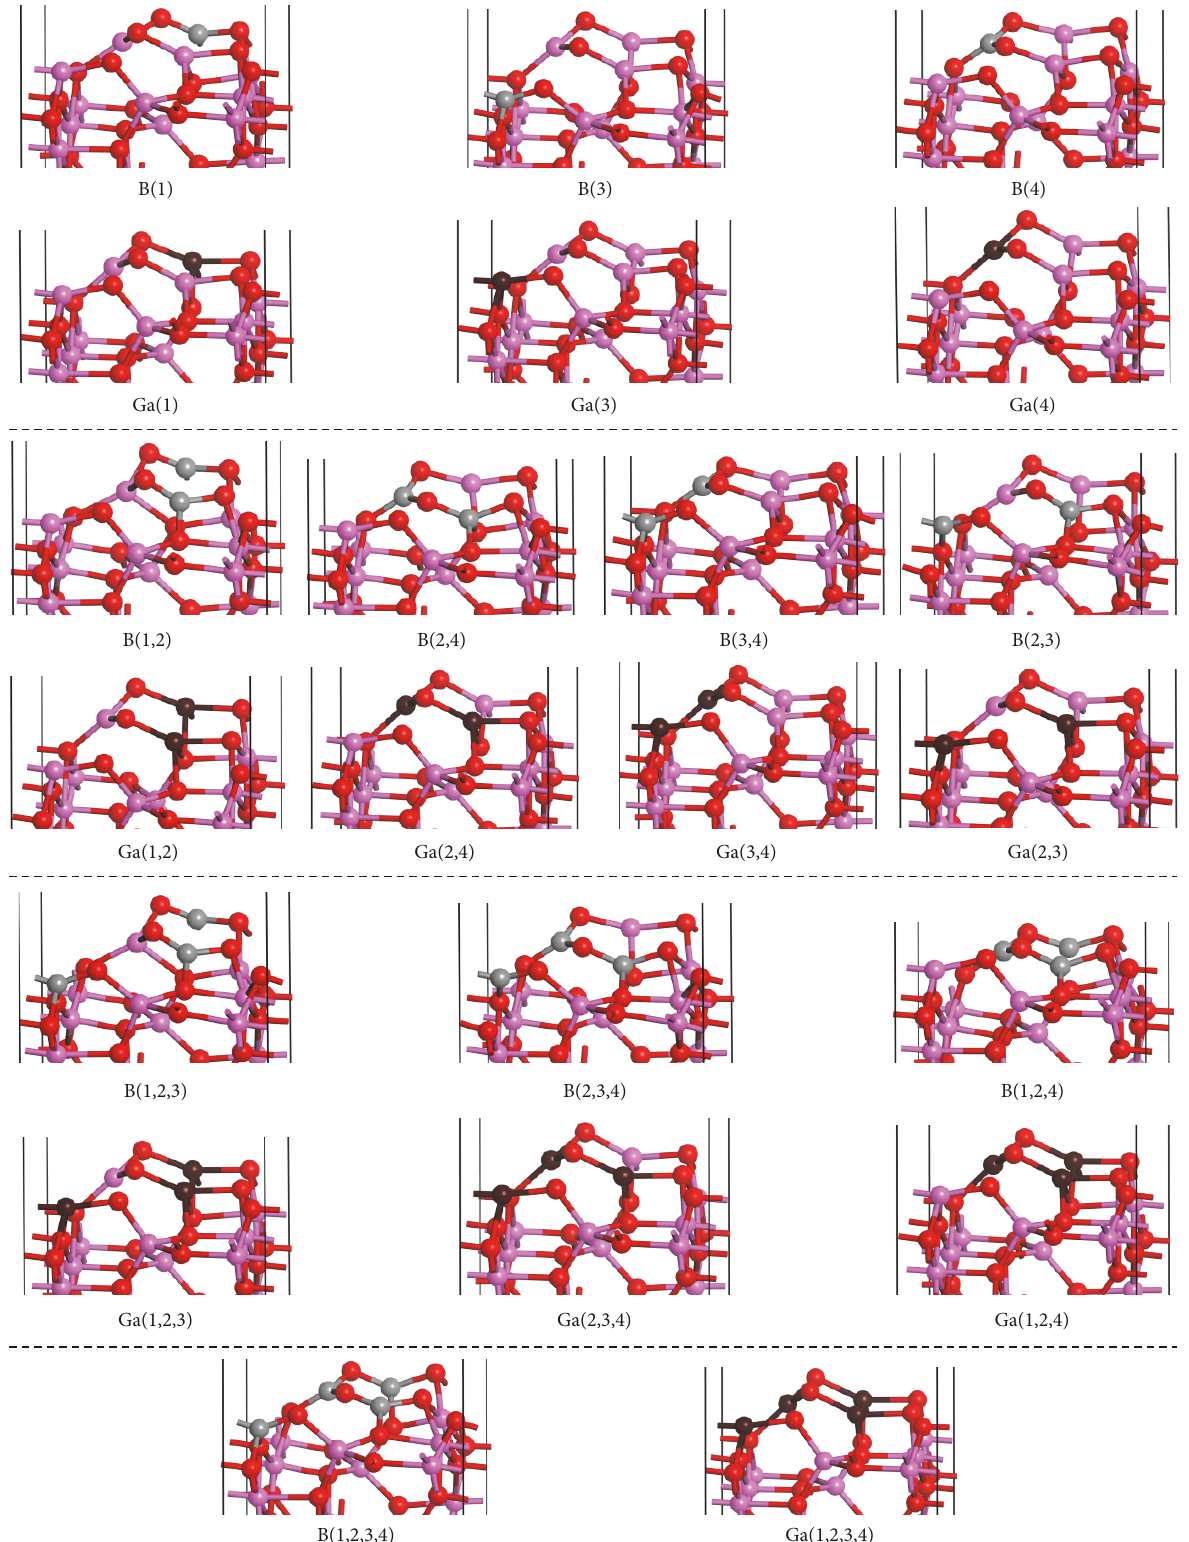
Figure 2: Side views of the B and Ga substituted 𝛾 -Al 2 O 3 (110) surface (B, Al, Ga, and O atoms are in gray, rose, dark, and red, resp.). All figures are indexed corresponding to Table